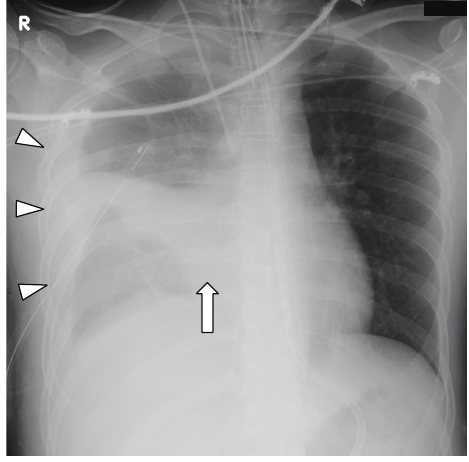
Figure 1: Chest radiograph obtained on the fourth day after admission shows right middle lobe atelectasis (arrow) and right- sided hemothorax (arrowhead).